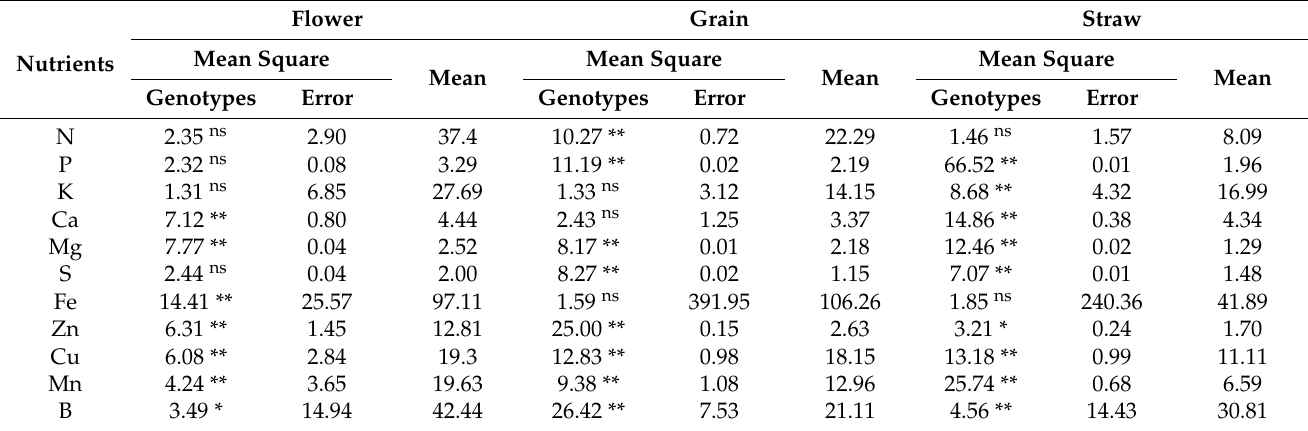
Table 5. Summary of analysis of variance for nutrient concentration in flowers, grains and straw of nine Coffea canephora genotypes. S ã o Mateus, state of Esp í rito Santo—Brazil. Flower Grain Straw Mean Square Mean Square Mean Square Nutrients Mean Mean Mean Genotypes Error Genotypes